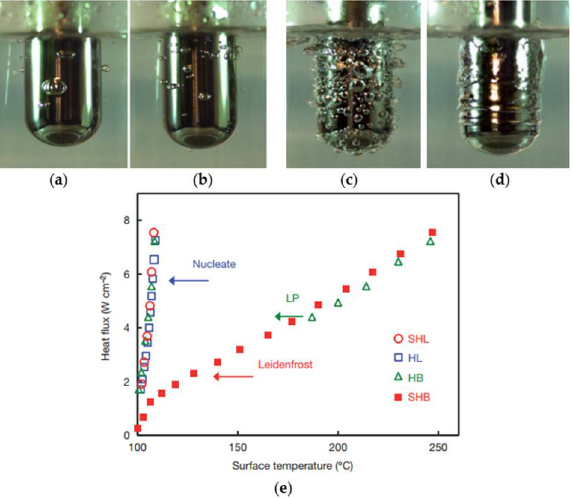
Figure 23. The heat transfer images on the superhydrophilic surface (SHL) ( a ), hydrophilic surface (HL) ( b ), hydrophobic surface (HB) ( c ), and superhydrophobic surface (SHB) ( d ). ( e ) The relation curve of heat flux and surface temperature. Reprinted with permission from Ref [115]. Copyright 2012 Springer Nature.